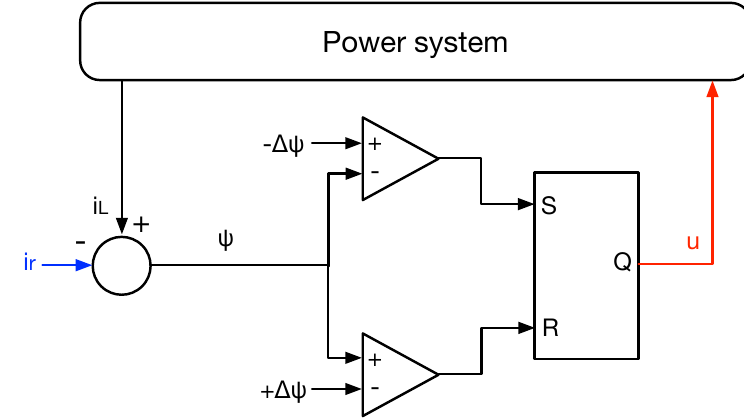
Figure 3. Circuital implementation of the